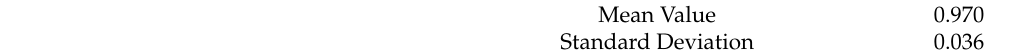
Figure 4. Pouring the concrete inside the CBPDS specimens; ( a )cover the C-Purlins sides, ( b ) provide openings, ( c ) pouring the concrete with vibrating, and ( d ) No concrete gap.